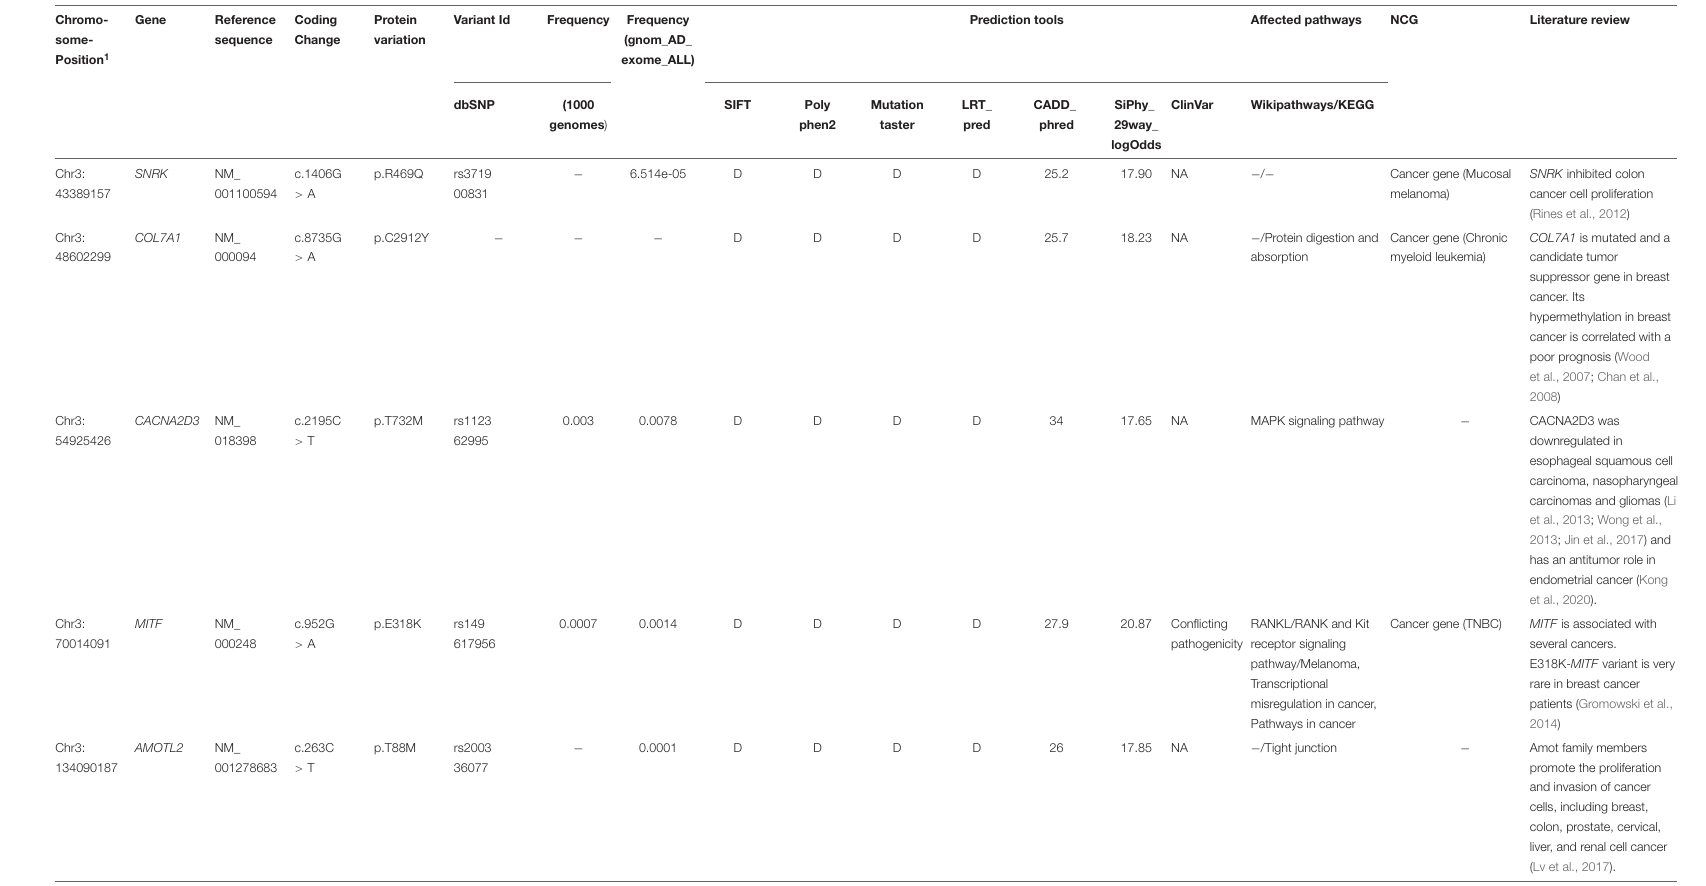
TABLE 2 | Candidate variations identified in whole exome sequenced breast cancer patient. Chromo- Gene Reference Coding Protein VariantId some- sequence Change variation Position 1